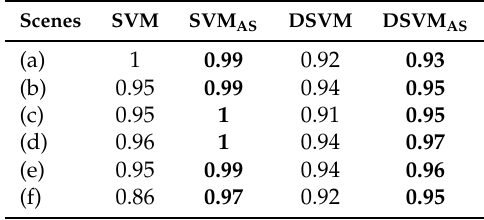
Table 6. F 1 score for the 512 × 512 resolution scenes. The bold values simply indicate the maximum F 1 score.